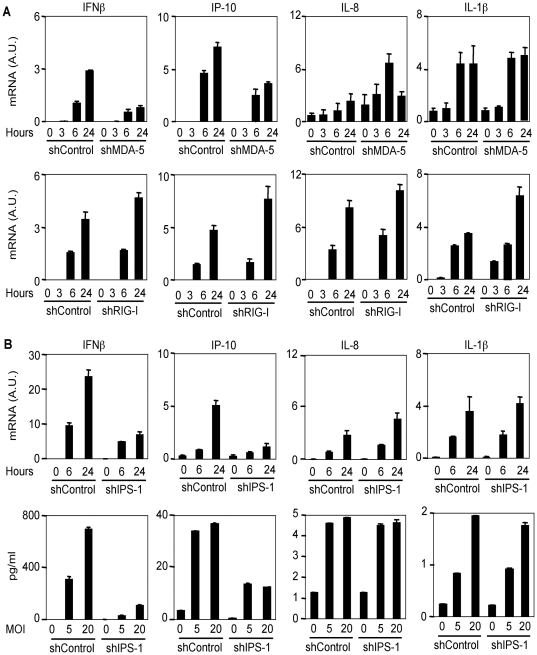
MVA is sensed by MDA-5 and not by RIG-I.THP-1 cells stably transduced with control, MDA-5, RIG-I or IPS-1 shRNAs were infected with MVA (MOI 5 unless specified otherwise) for the indicated time. IFNβ, IP-10, IL-8 and IL-1β mRNA and protein expression by RT-PCR and ELISA (A–B). Results are expressed as the ratio of IFNβ, IP-10, IL-8 or IL-1β mRNA levels to that of HPRT. Data are means±SD of triplicate samples from one experiment and are representative of four independent experiments. AU: arbitrary units. Concentrations of IFNβ and IL-8 in cell-culture supernatants were measured 24 h after stimulation. shMDA-5 and shIPS-1 THP-1 cells produced significantly less IFNβ and IP-10 mRNA and protein than control cells as measured 24 h post-infection (A and B) (p<0.05).